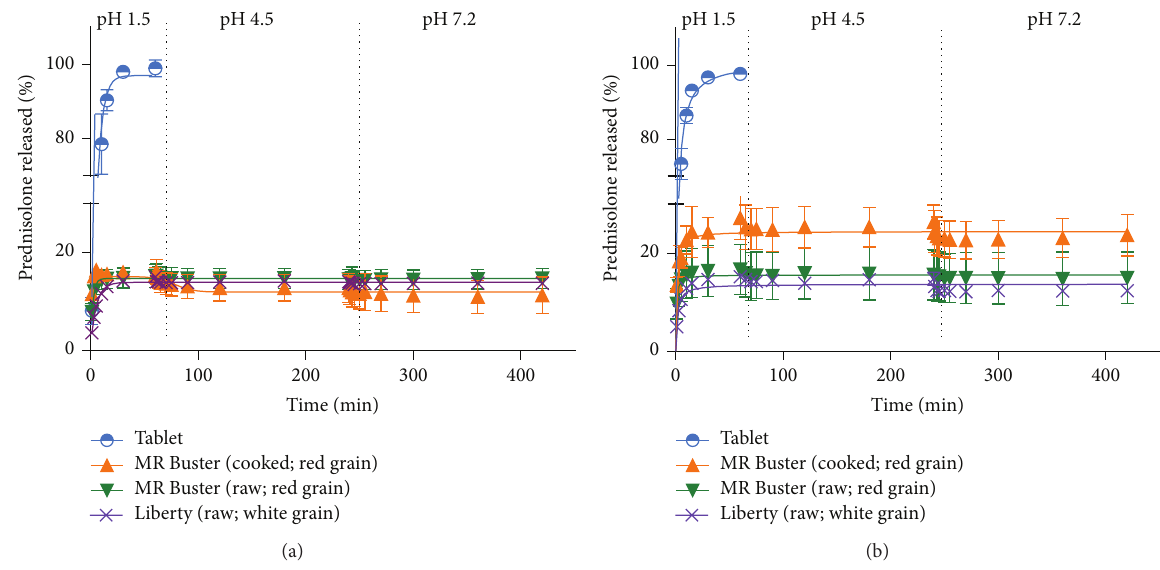
Figure 2: In vitro drug release profile of a commercially available 5 mg prednisolone tablet compared to prednisolone release from the three different types of kafirin microparticles containing 5mg prednisolone. Prednisolone release was measured in conditions simulating the stomach for 1h, followed by the small intestine for 6h, (a) without enzymes and (b) in the presence of the enzymes pepsin and pancreatin. Values are mean ± SEM ( 𝑛 = 3 ).